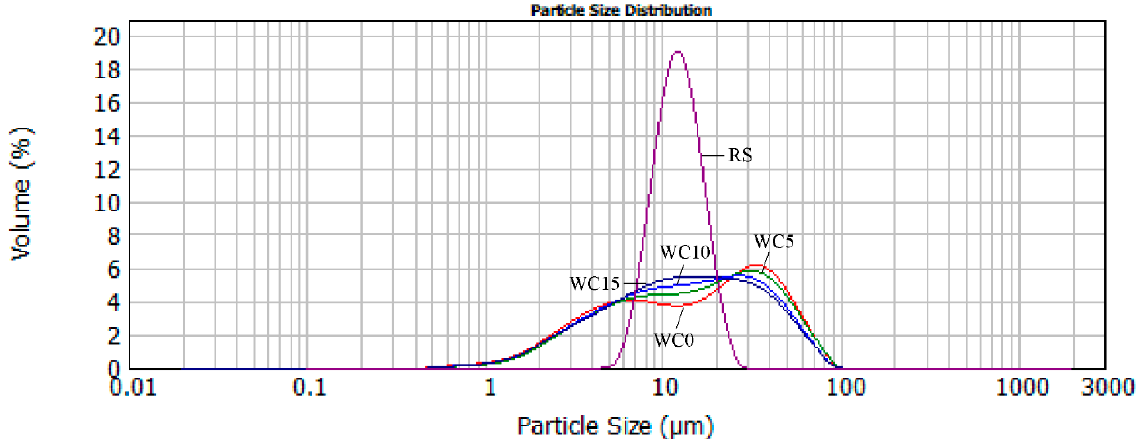
Figure 2. Particle size distribution of RS, white chocolate, and enriched chocolate samples. The parameters of the particle size distribution of RS and chocolate samples are presented in Table 3. Particle size parameters of RS and enriched chocolate.